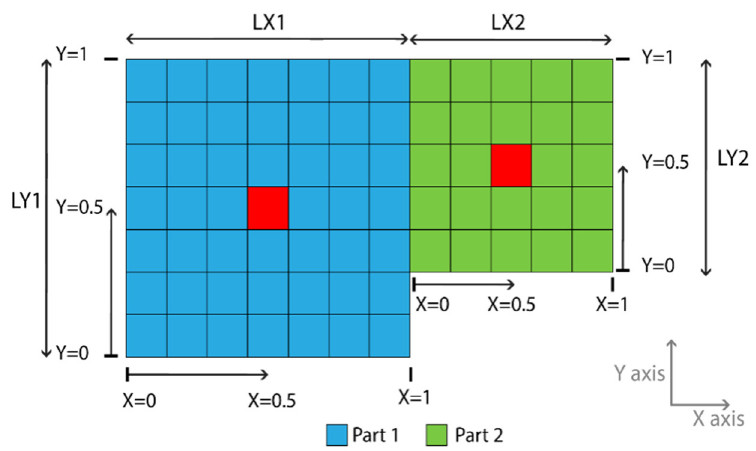
Figure 1. Example of the damaged area center selection in two parts.